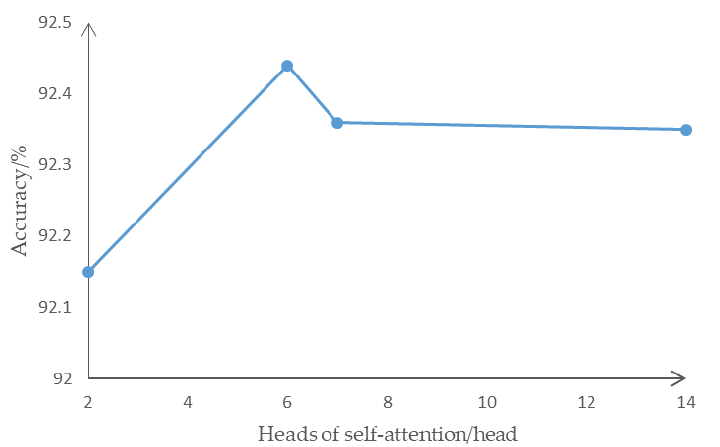
Figure 10. The prediction accuracy of different heads of self-attention.